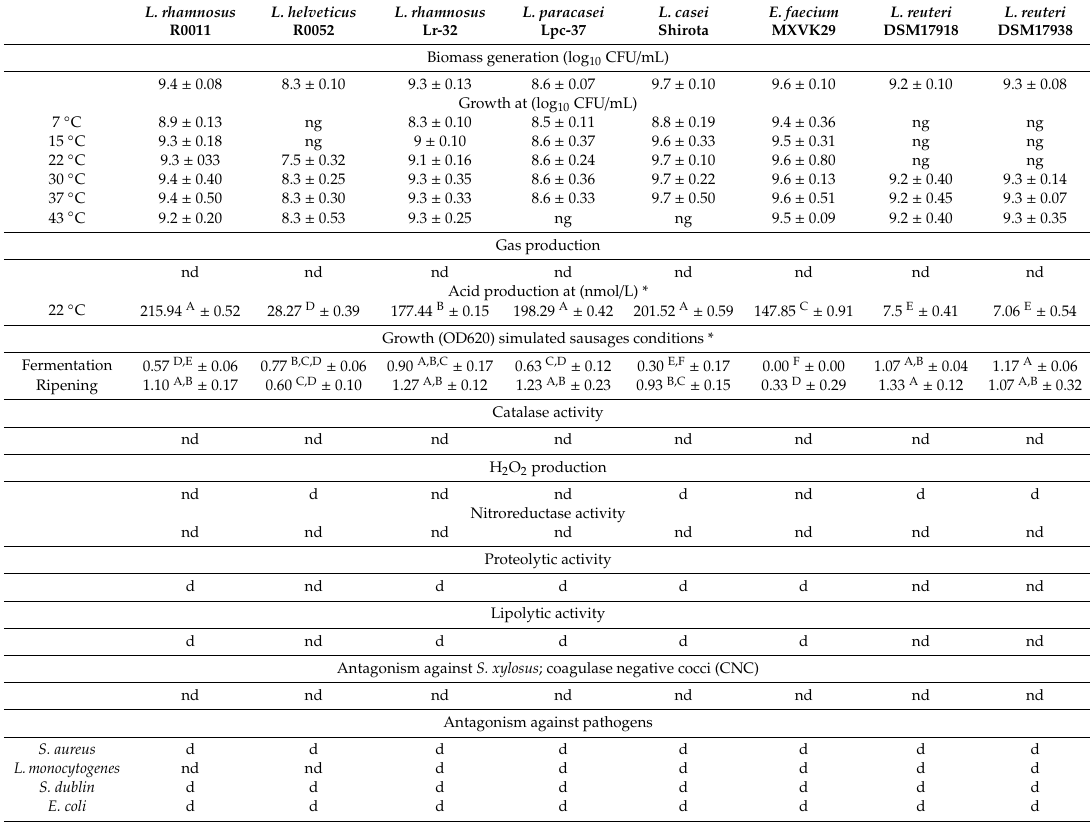
Table 2. Technological and safety features of commercial probiotic bacteria.